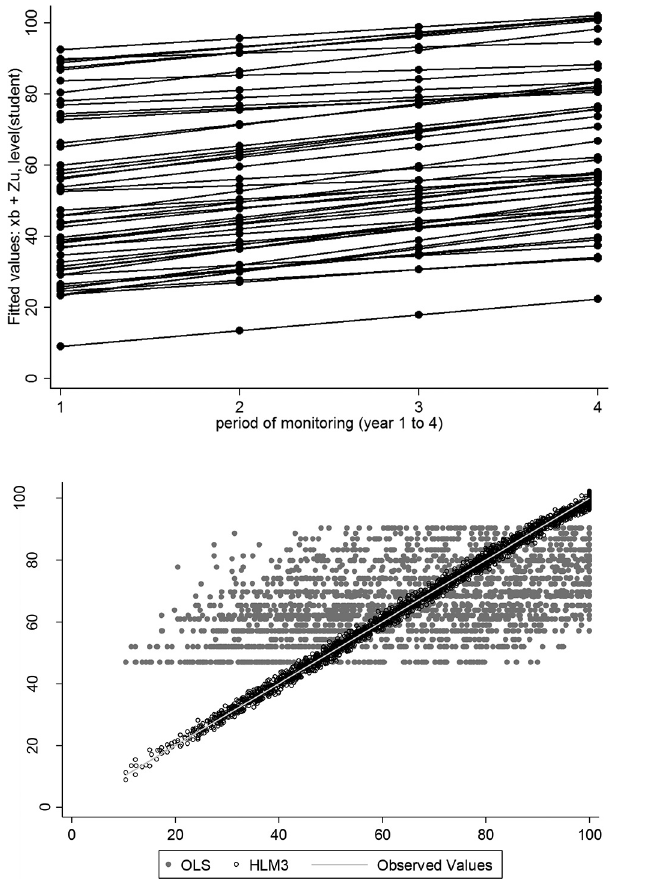
Figure 17. Values predicted through OLS and through HLM3 (cid:5) observed school performance